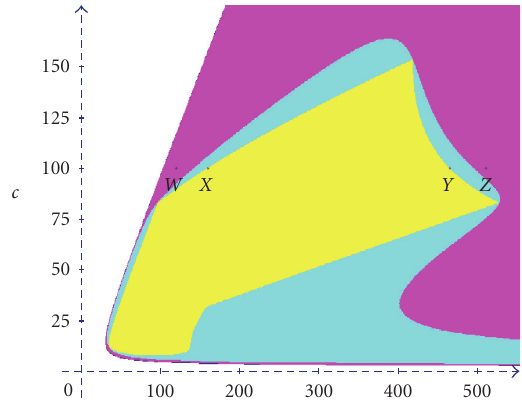
Figure 7.1 . Regions of su ffi cient stability condition and necessary and su ffi cient stability condition for (5.2): p = 12, h = 0 . 024, Δ = 0 . 012.